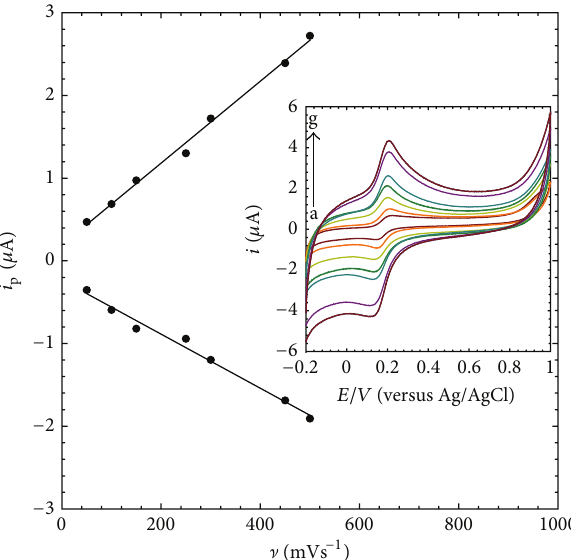
Figure 5: Linear relationship of 𝑖 of DA oxidation/reduction and p scan rate ( ] ) at the MCPE/MNP. Inset is the cyclic voltammograms of the MCPE/MNP in PBS, DA free, pH 7.0, and 0.1M NaClO 4 after 30 min pre-concentration in PBS (pH 7.0) containing 1mM DA with different scan rates ((a)–(g): 50, 100, 150, 250, 300, 450, and 500 mVs −1